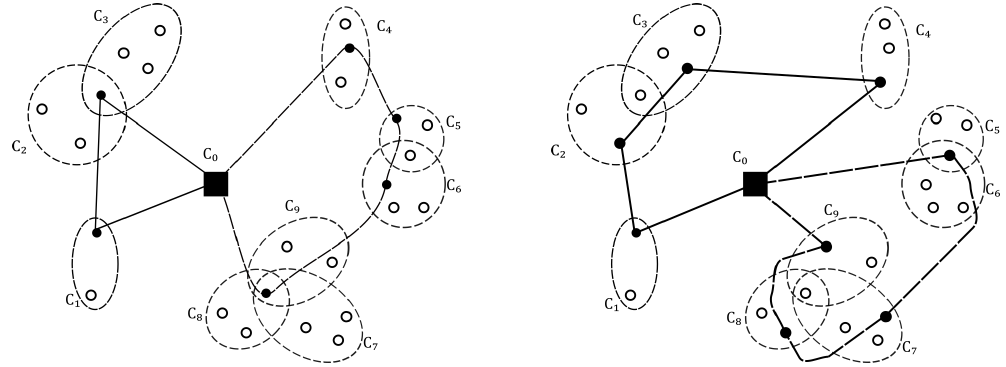
Figure 1. An illustrative example of the SVRP and two feasible